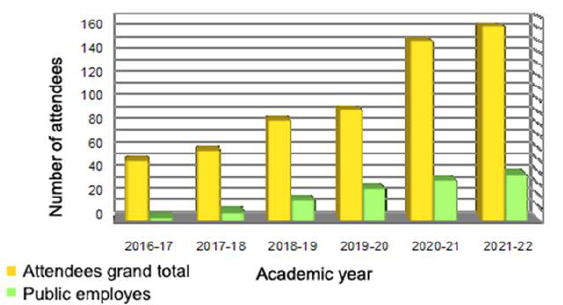
Figure 4 . Public workers total percentage attending the Master (Figure by P.